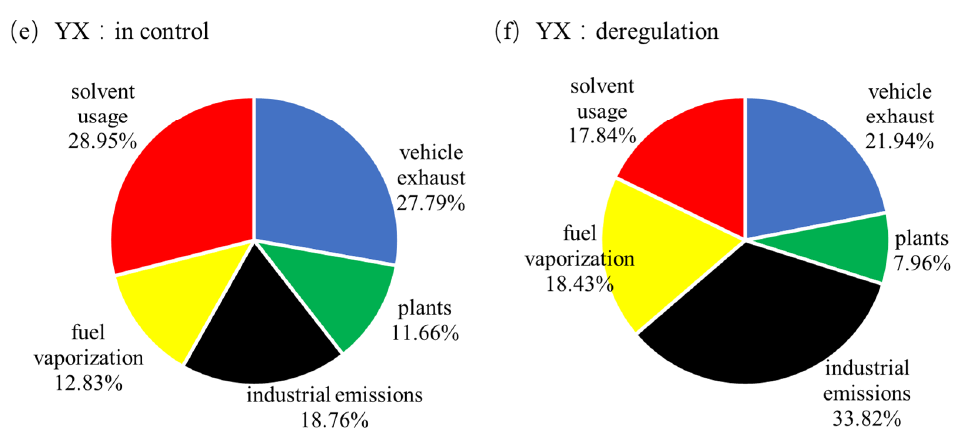
Figure 9. Source apportionment of VOCs at the ZH (( a ) in control, ( b ) deregulation), DSL (( c ) in control, ( d ) deregulation) and YX (( e ) in control, ( f ) deregulation) sites during different periods of G20 Summit.